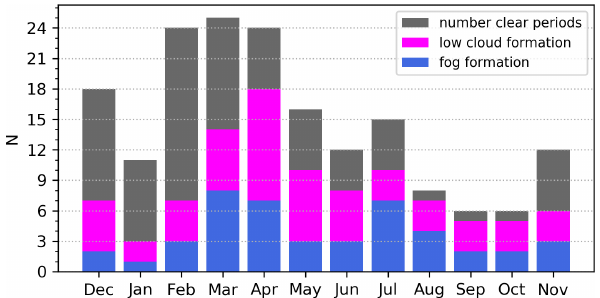
Figure 2. Monthly occurrences of clear-sky periods determined from the remote sensing suite at ARM-NSA during 2014 to 2018 (gray bars). Magenta bars represent the number of clear-sky events that ended with the formation of a low cloud layer (cloud base be- low 400ma . g . l . ) and blue bars the events with fog